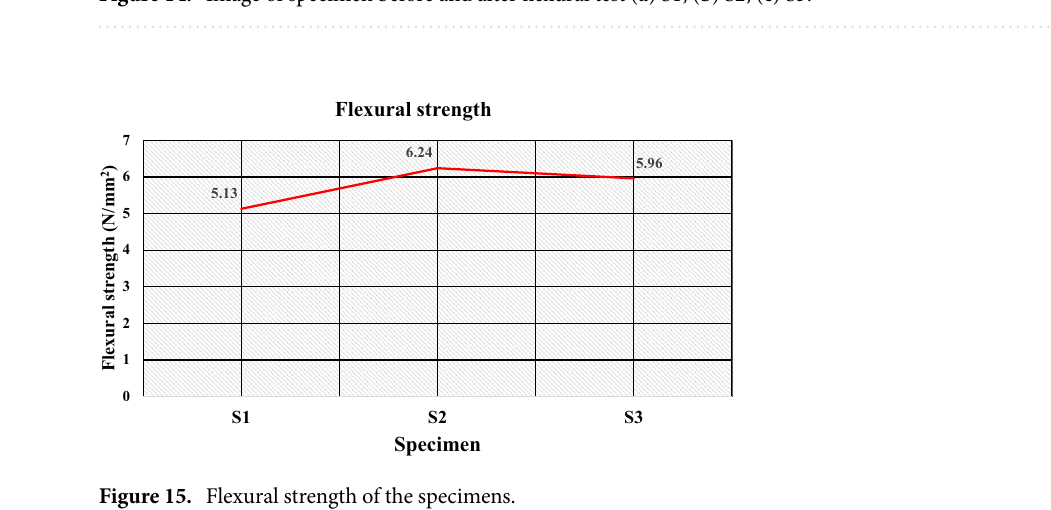
Figure 14. Image of specimen before and after flexural test ( a ) S1, ( b ) S2, ( c ) S3.